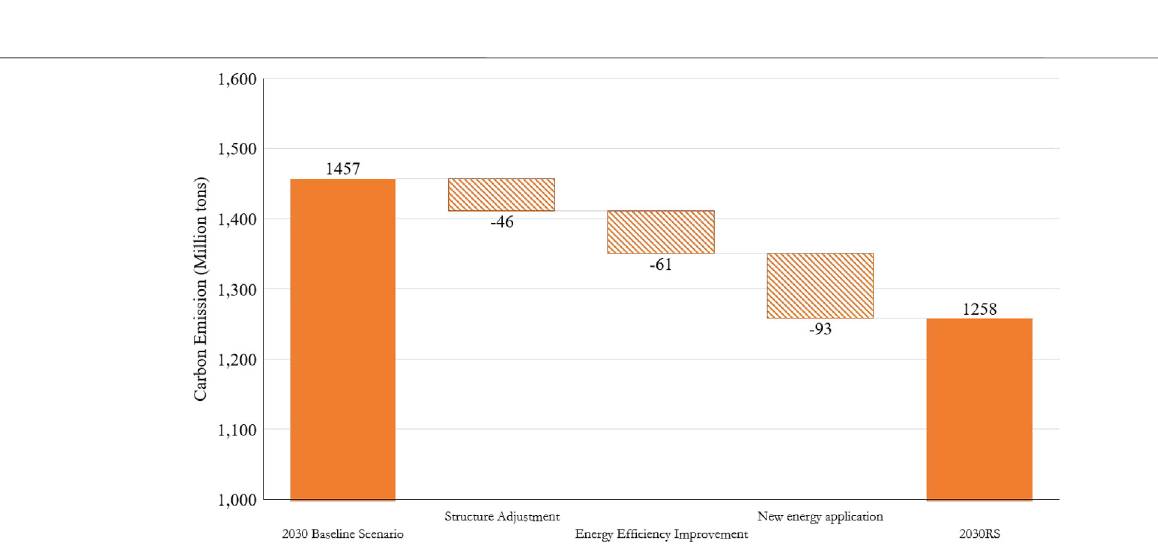
Frontiers in Environmental Science |